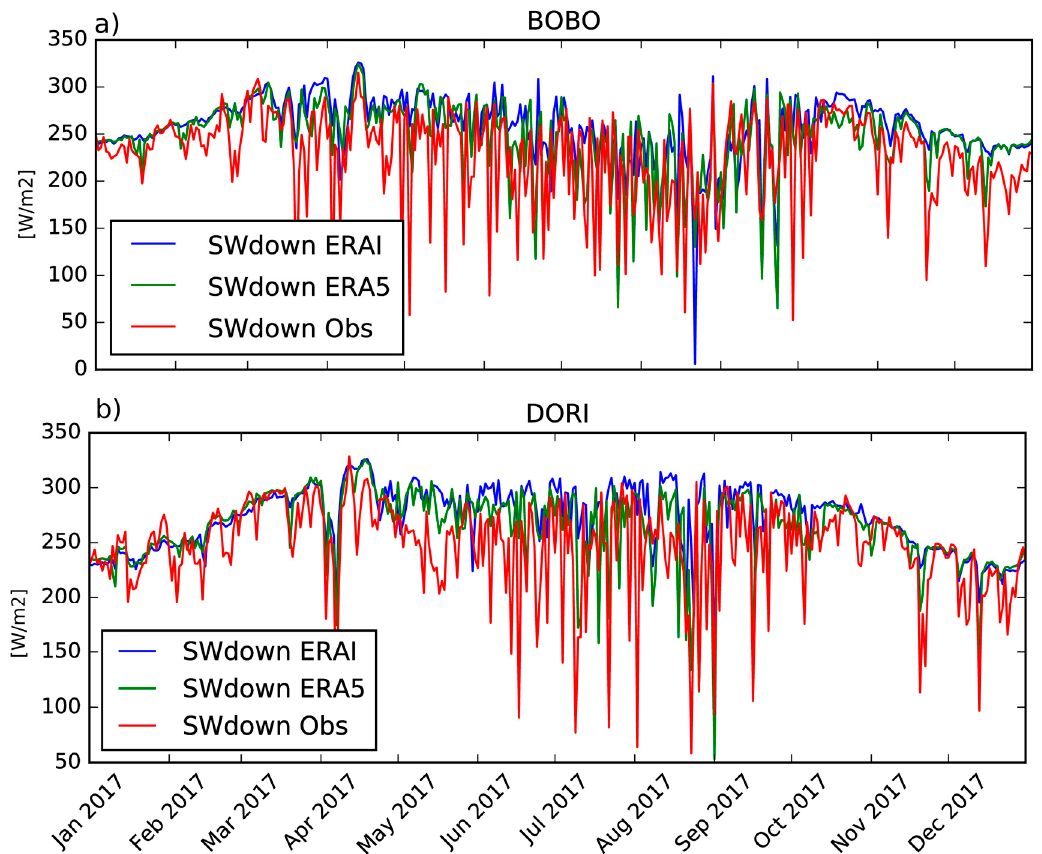
Figure 5. Incoming solar radiation temporal evolution for ERA-Interim, ERA5, and in situ measurements for (a) Dori and (b) Bobo stations for